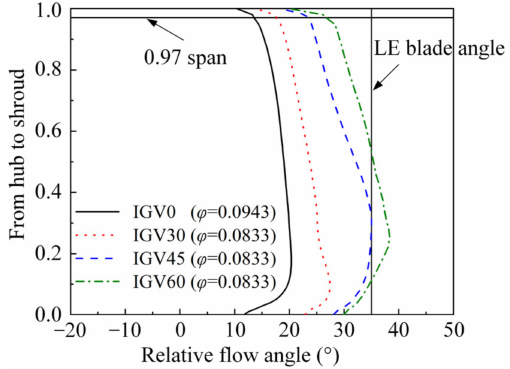
Figure 7. Relative flow angle distributions at the impeller